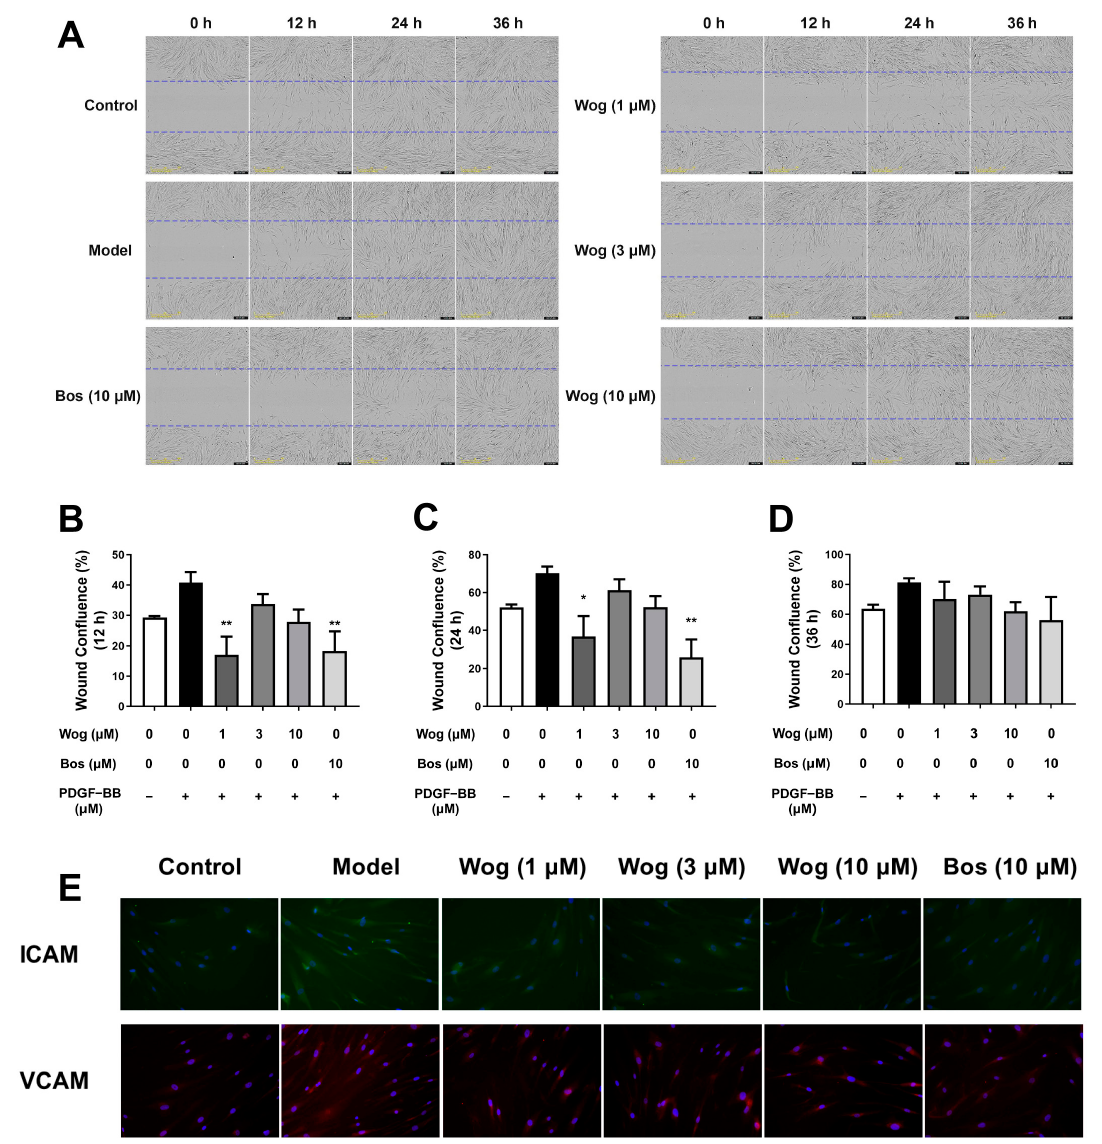
Figure 7. Wogonin inhibits PDGF-BB-mediated migration of PASMCs. ( A ) Microscopic image of wound healing experiment of PASMCs at 0, 12, 24, 36 h. ( B ) Wound confluence of PASMCs at 12 h ( B ), 24 h ( C ), and 36 h ( D ). ( E ) Effect of wogonin on ICAM and VCAM expression in PASMCs (original magnification ×200). Results are presented as mean ± SEM (n = 3). * p < 0.05, ** p < 0.01 vs. model group.